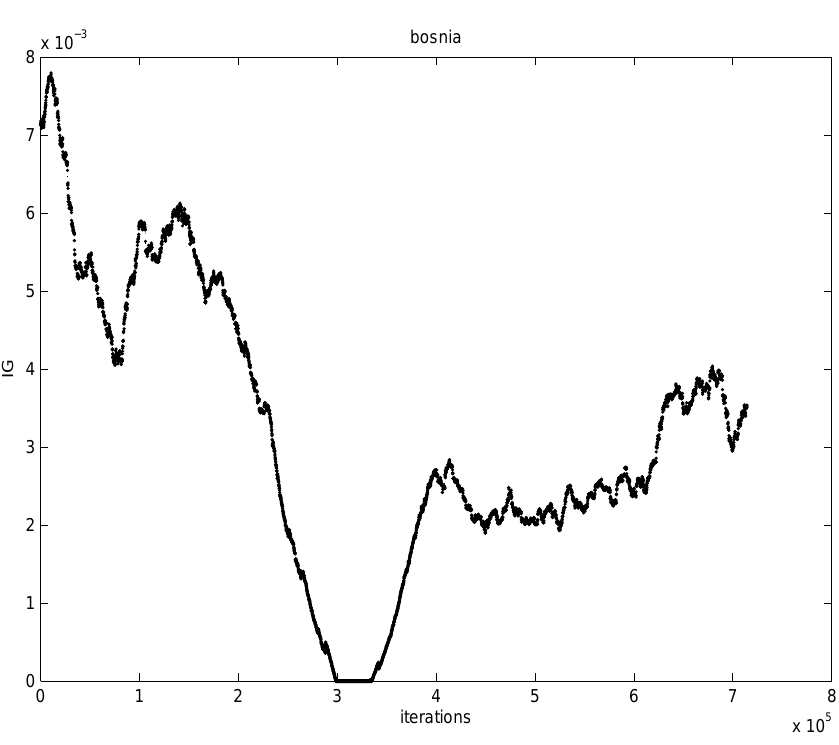
Figure 5. information gain values for the feature “bosnia”.